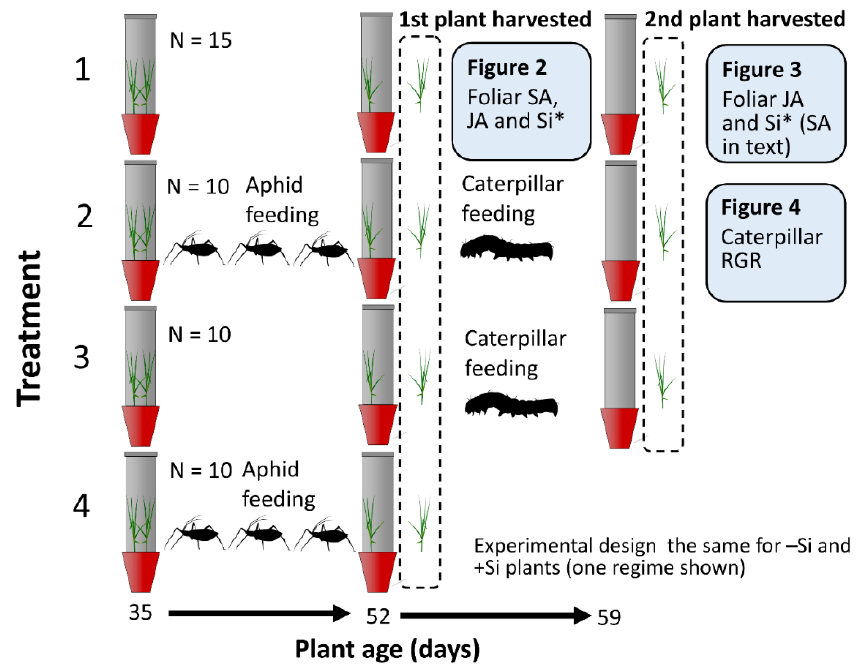
Figure 1. Schematic of the experimental design summarizing the sequence of treatments, replication and how these relate to results in subsequent figures. The full experiment was replicated for − Si and + Si plants (one regime shown for clarity). * Si concentrations analyzed on + Si plants only since − Si plants were not supplied with Si.